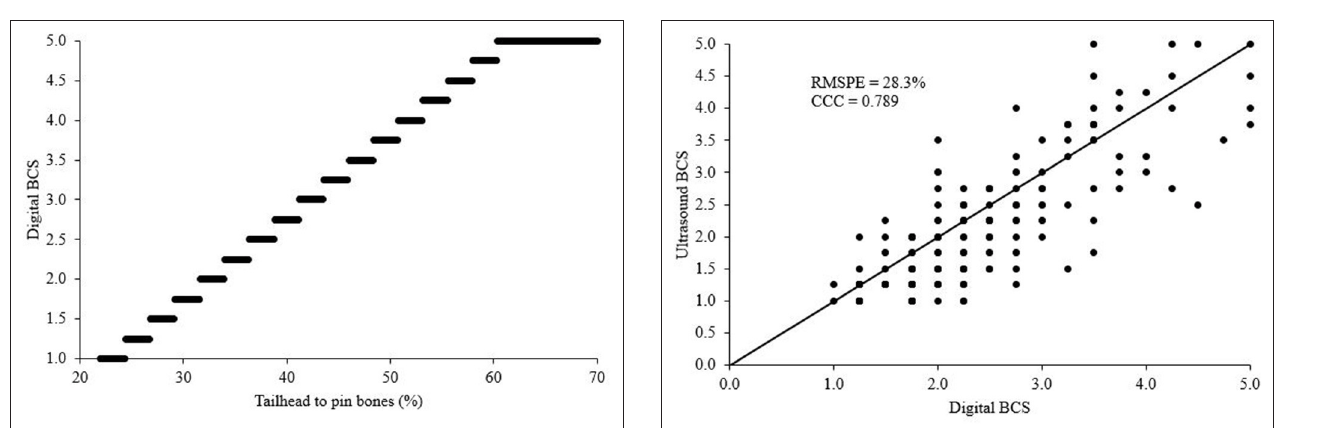
FIGURE 8 | Relationship between digital and ultrasound body condition score (BCS). Root mean square prediction error (RMSPE) expressed as a percentage of the observed mean for ultrasound BCS and Lin’s concordance correlation coefficient (CCC) are shown, and the 45 ◦ line through the